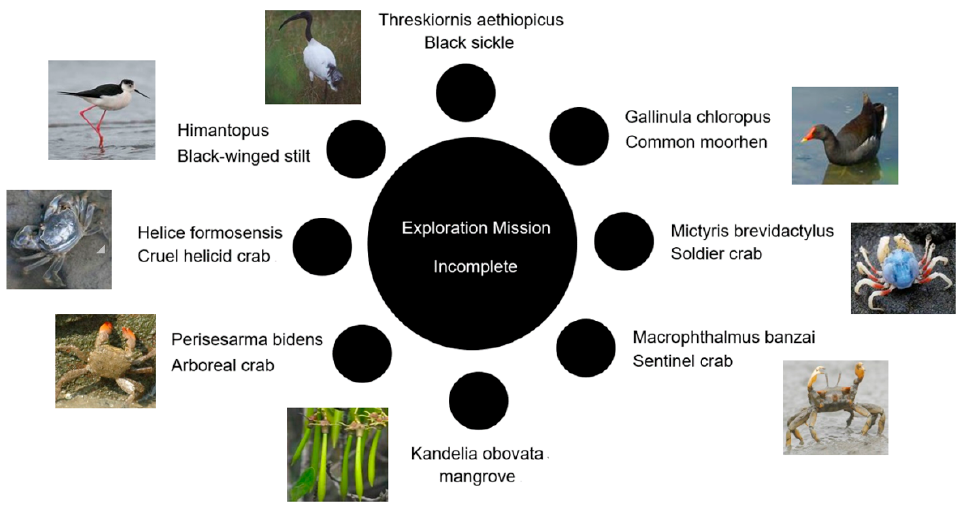
Figure 7. The observation tasks of finding creatures in the virtual wetland areas.